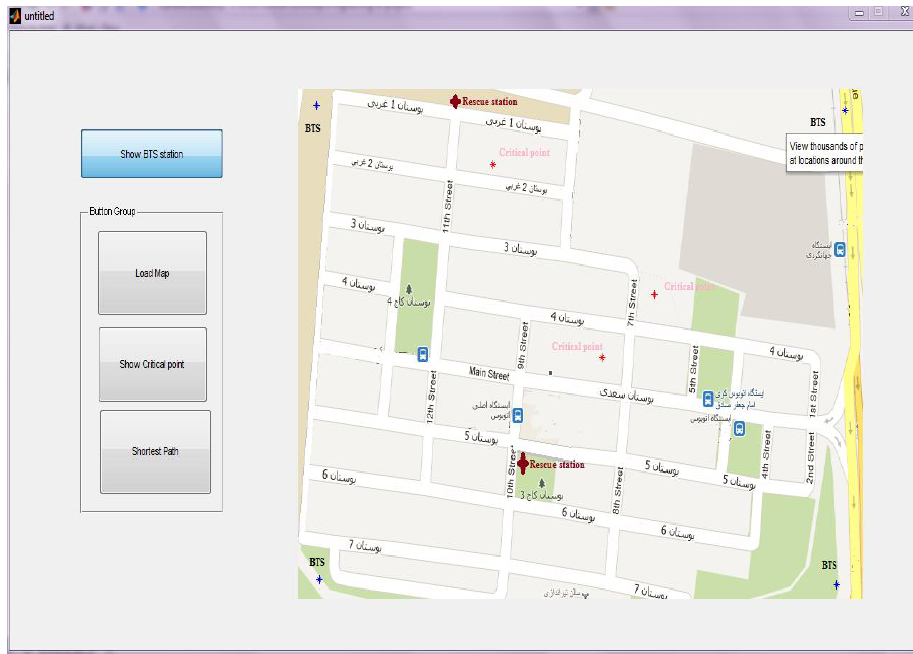
Figure 8. Program interface (critical points, BTSs, rescue